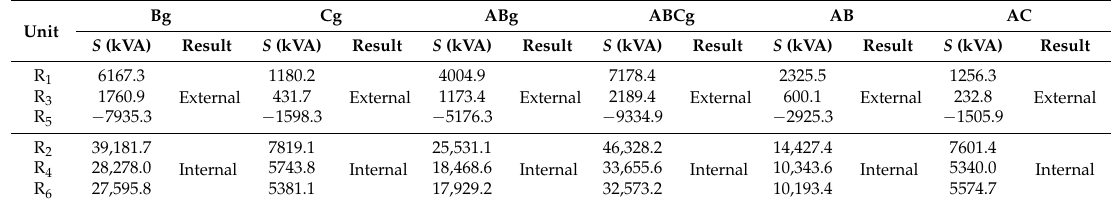
Table 6. Simulation results of the different fault types for the busbar II faults.